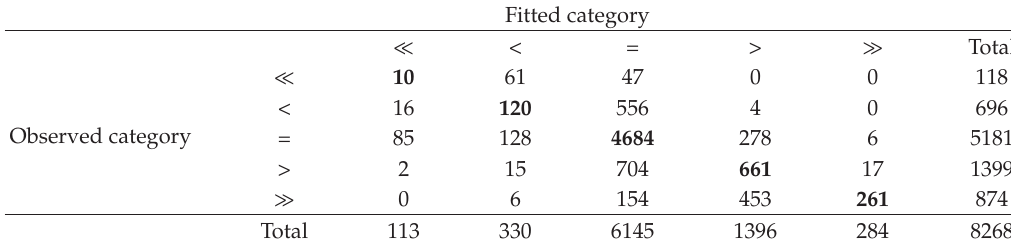
Table 6: Crosstab of observed and fitted